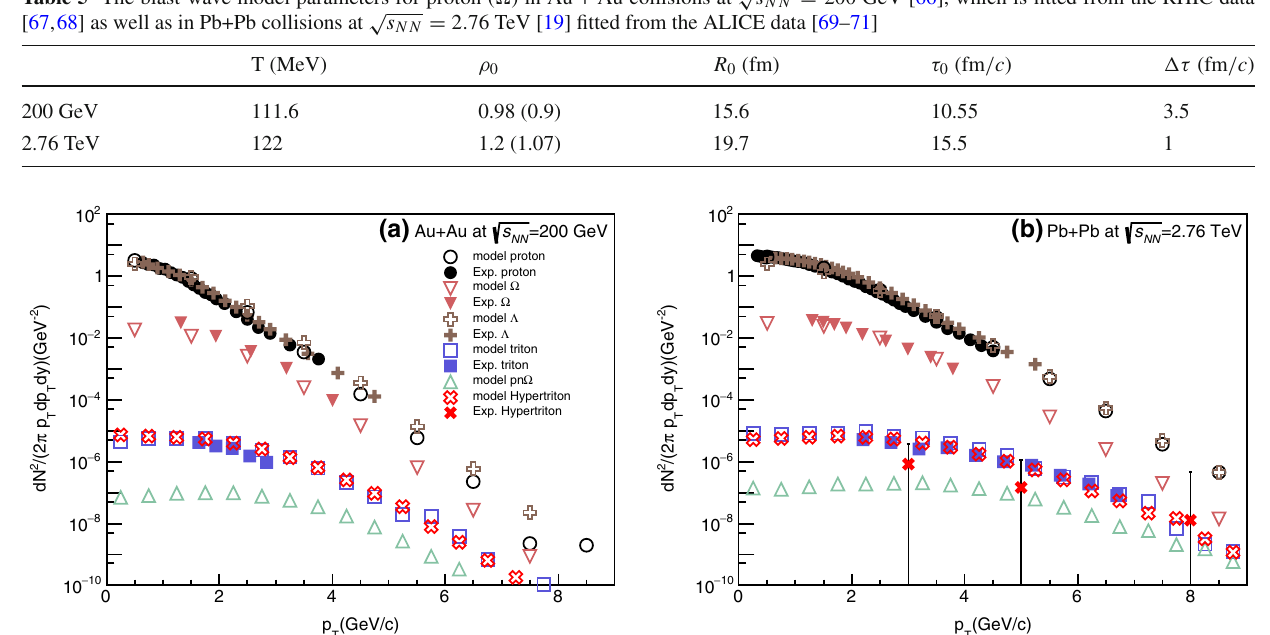
√ s NN = 200 GeV [66], which is fitted from the RHIC data